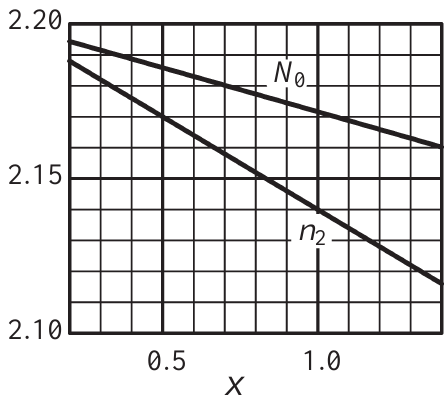
Figure 2. The core radius, a , and the parameter, ∆ = waveguide as a function of Ga content, x , in yttrium iron garnet, Y 3 Fe 5 The symbols n 1 and n 2 denote the indices of refraction in the core and in the cladding, respectively. The V number was fixed at V = 2.400. −